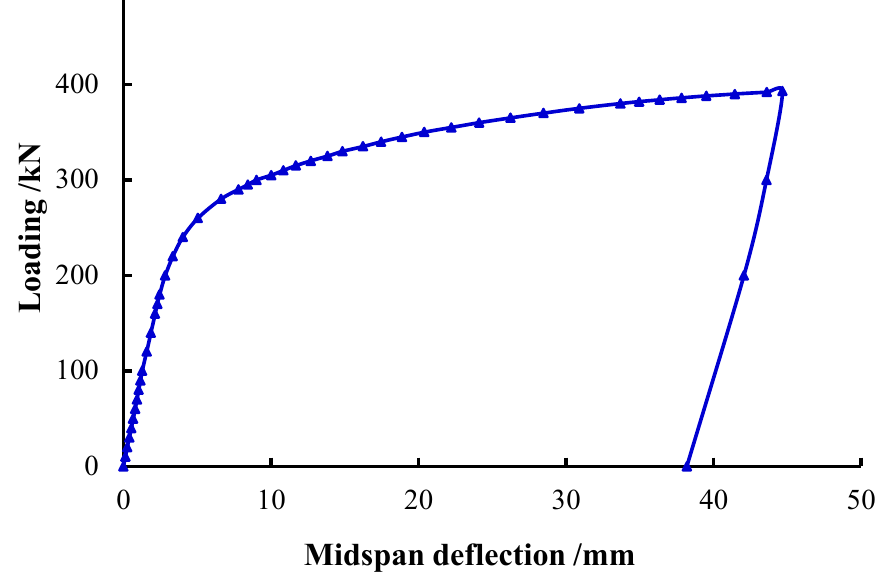
Figure 5. Typical load–midspan deflection curve.